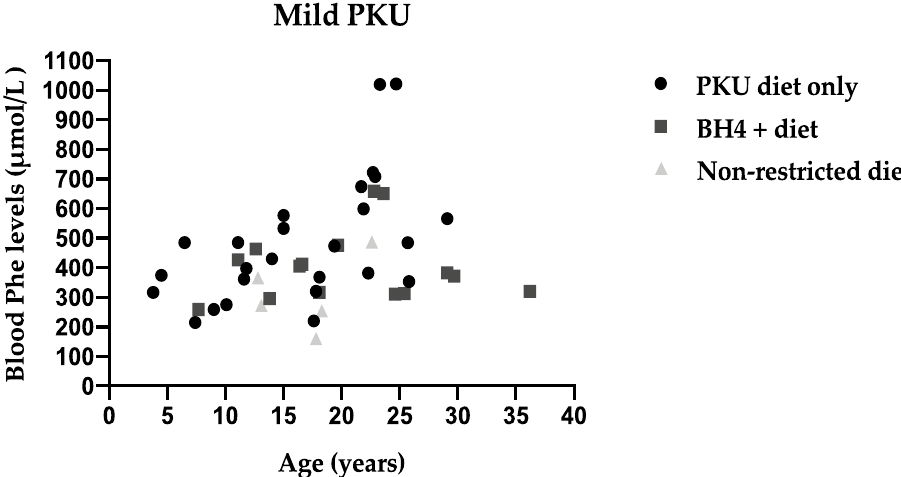
Figure 2. Median annual blood Phe levels for each individual patient with mild PKU by age and type of treatment.